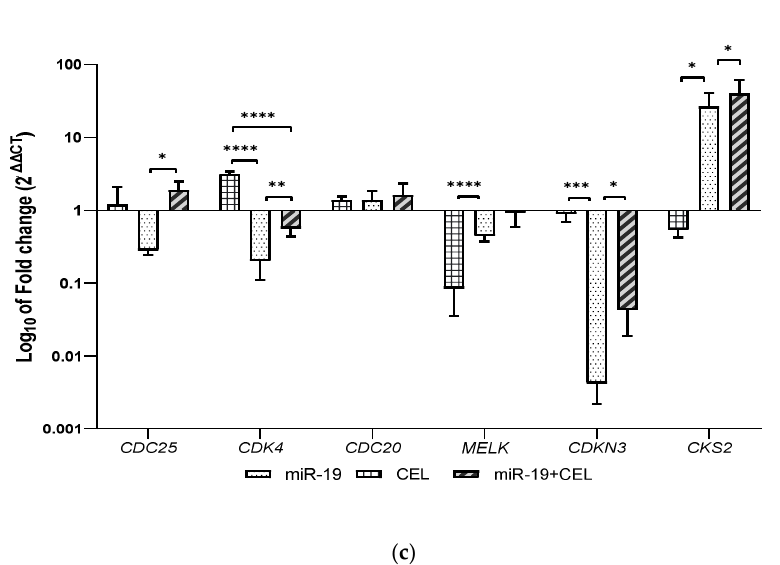
Figure 3. The RT-qPCR analysis for the genes related to the cell cycle after 24 h of treatment with 1 µM celastrol, 0.25 nM miR-9-2, miR-17, miR-19 specific siRNA (miR-9-2, miR-17, miR-19) and the combination of celastrol with knockdown of the miR-9-2 , miR-17 and miR-19 genes (miR9-2 + CEL, miR-17 + CEL, miR-19 + CEL) is presented as the fold change (2 −∆∆CT ) in the level of their expression, which was normalized to the TBP reference gene. C (control) untreated cells. The data are expressed as the mean ± SD ( n = 6 independent assays); statistically significant * p < 0.05, ** p < 0.01, *** p < 0.001, **** p < 0.0001, ordinary one-way ANOVA followed by Tukey’s post-hoc test. ( a ) The U251MG cells that had been exposed to celastrol (1 µ ; CEL) for 24 h, the siRNA that is specific for miR-9-2 (0.25 nM; miR-9-2) for 48 h or a combination of the siRNA that is specific for miR-9-2 (0.25 nM) for 48 h and celastrol (1 µ ) for 24 h (miR-9-2 + CEL). ( b ) The U251MG cells that had been exposed to celastrol (1 µ ; CEL) for 24 h, the siRNA that is specific for miR-17 (0.25 nM; miR-17) for 48 h or a combination of the siRNA that is specific for miR-17 (0.25 nM) for 48 h and celastrol (1 µ ) for 24 h (miR-17 + CEL). ( c ) The U251MG cells that had been exposed to celastrol (1 µ ; CEL) for 24 h, the siRNA that is specific for miR-19 (0.25 nM; miR-19) for 48 h or a combination of the siRNA that is specific for miR-19 (0.25 nM) for 48 h and celastrol (1 µ ) for 24 h (miR-19 + CEL). We found that the changes in the cell cycle-related genes after the miR-17 knockdown were mainly manifested in a decreased CDC25A , CDK4 and CDKN3 (comparable to com- bining with the miR-17 gene silencing and celastrol exposure) gene expression and an increased CKS2 gene expression (comparable with the combination with celastrol). The knockdown of the miR-17 gene in combination with celastrol increased the CKS2 gene expression more strongly than just silencing the miR-17. Only the knockdown of the miR- 17 gene decreased the expression of the CDKN3 gene (Figure 3b; Table 2) We also revealed that the changes in cell cycle-related genes after the miR-19 knock- down were mainly manifested in a decreased CDC25A , CDK4 , MELK and CDKN3 gene